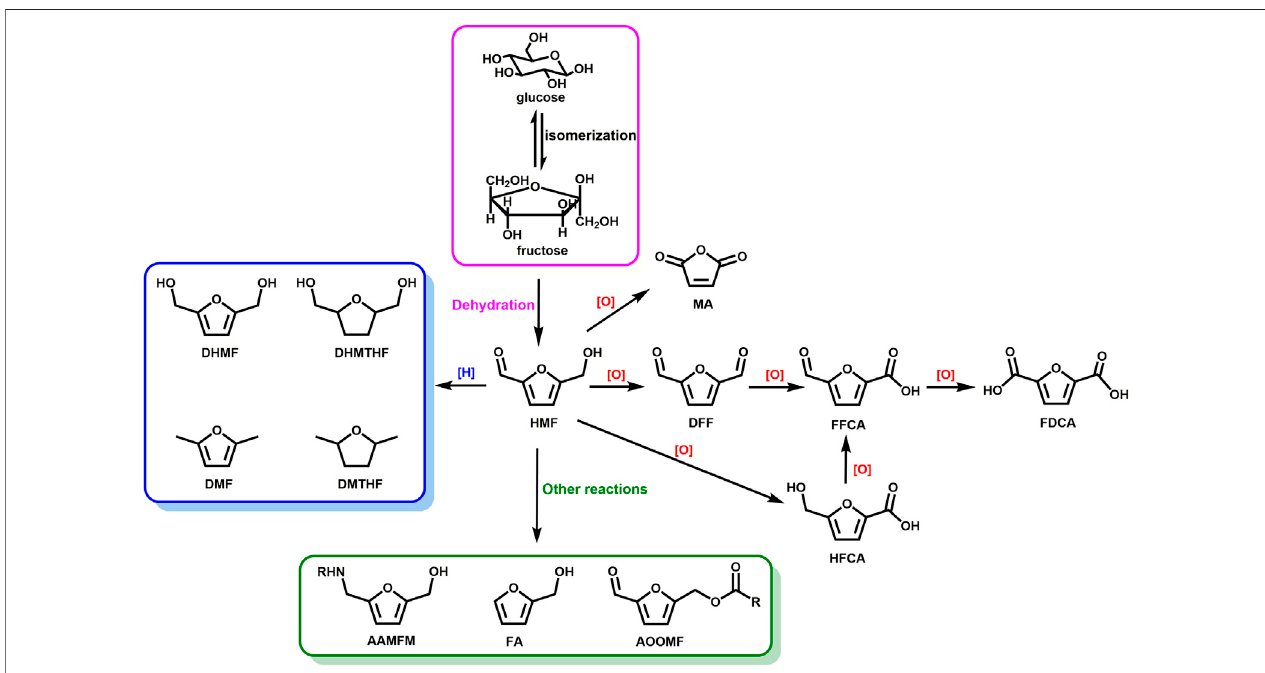
FIGURE6| CatalyticconversionofHMFintovariousvaluableproducts.DFF,HFCA,FFCA,MA,FDCA,DHMF,DHMTHF,DMF,DMTHF,AAMFM,FA,andAOOMF denote 2,5-diformylfuran, 5-hydroxymethyl-2-furancarboxylic acid, 5-formyl-2-furancarboxylic acid, maleic anhydride, 2,5-furandicarboxylic acid, 2,5- dihydroxymethylfuran, 2,5-dihydroxymethyltetrahydrofuran, 2,5-dimethylfuran, 2,5-dimethyltetrahydrofuran, 5-arylaminomethyl-2-furanmethanol, furfuryl alcohol, and